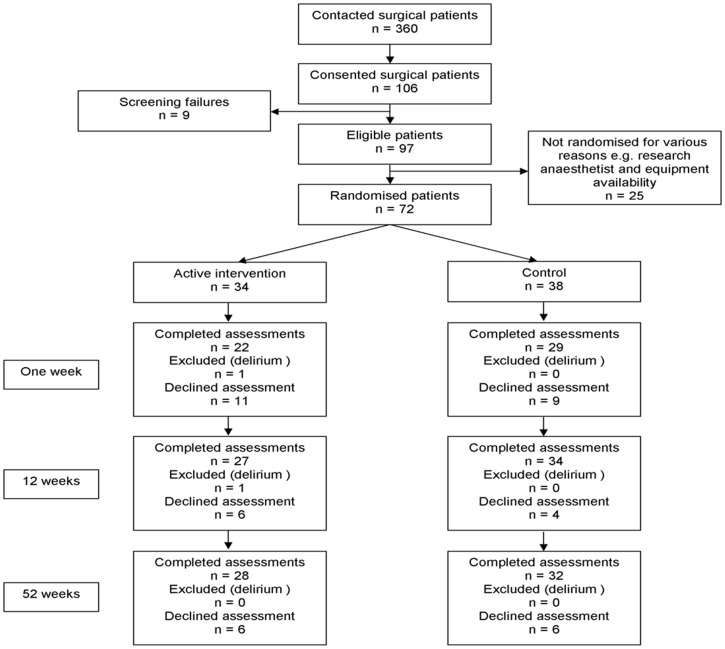
CONSORT chart showing flow of participants through the trial.Assessment of POCD required completion of seven cognitive assessments which were not all completed for all individuals at all timepoints. Presence/absence of POCD was therefore determined as follows throughout the trial. Week 1: Intervention group – 19, Control group – 28; Week 12: Intervention group – 24; Control group – 33; Week 52: Intervention group 27; Control group – 32.